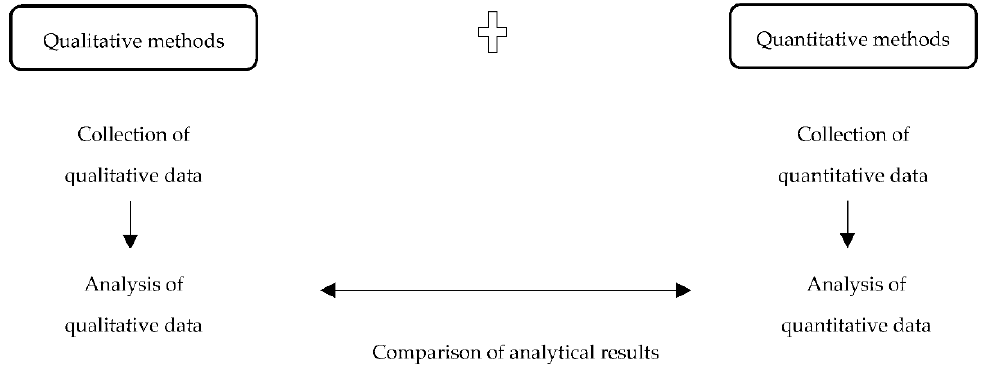
Figure 1. Parallel triangulation strategy. Source: own elaboration.